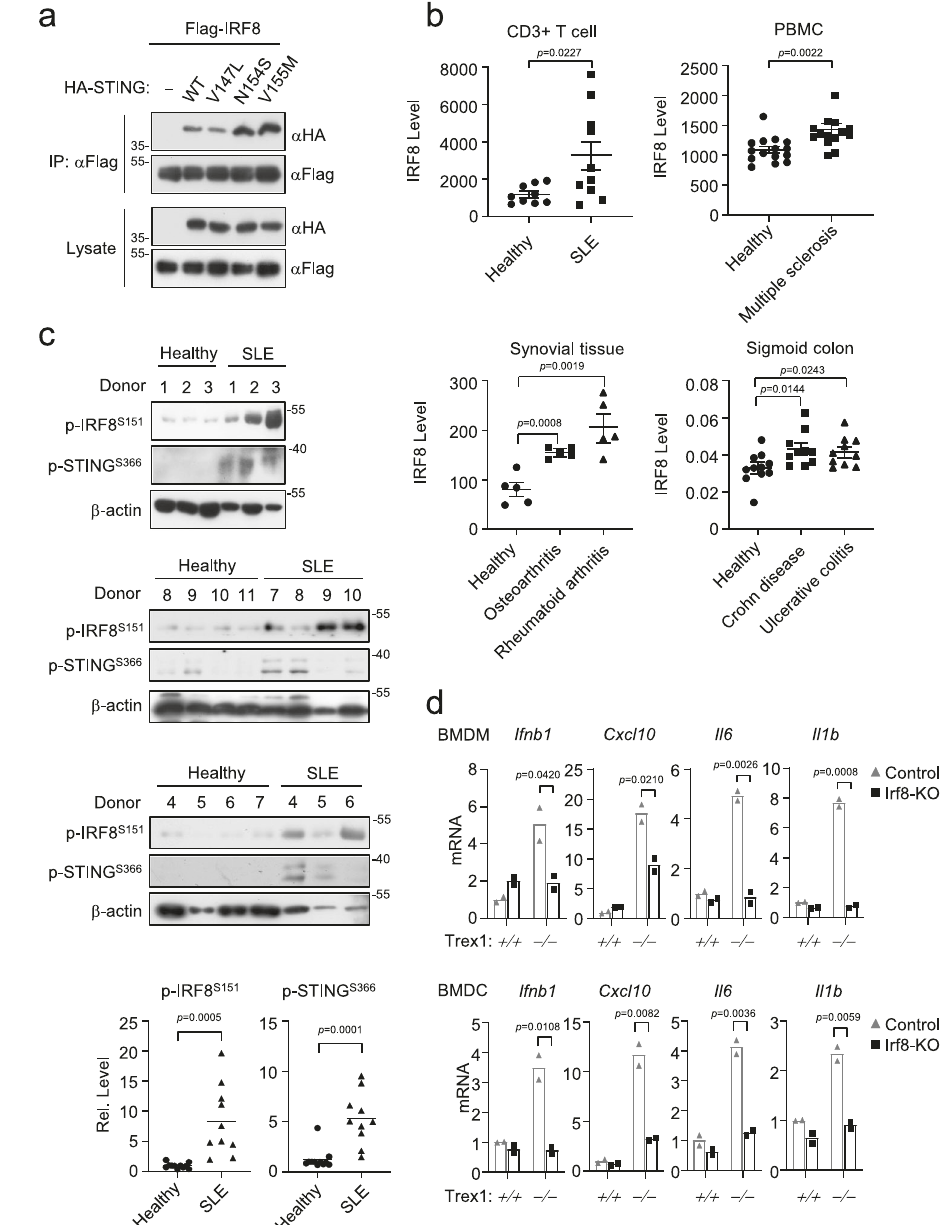
Fig. 7 | IRF8 is abnormally activated in autoimmune syndromes. a Coimmunoprecipitation of IRF8 and STING SAVI mutants in HEK293T cells. Cells were transfected with the indicated plasmids for 20h followed by coimmunopre- cipitation and immunoblotting analysis with the indicated antibodies. b Pro fi ling analysis of IRF8 expression in healthy donors and patients with autoimmune dis- eases.Graphshowsmean±SEM, n =5 – 15independentsamples.Datawereanalyzed by unpaired two-tailed Student ’ s t-test. c Immunoblotting analysis of IRF8 S151 and STING S366 in PBMCs from healthy donors ( n =11 independent samples) and